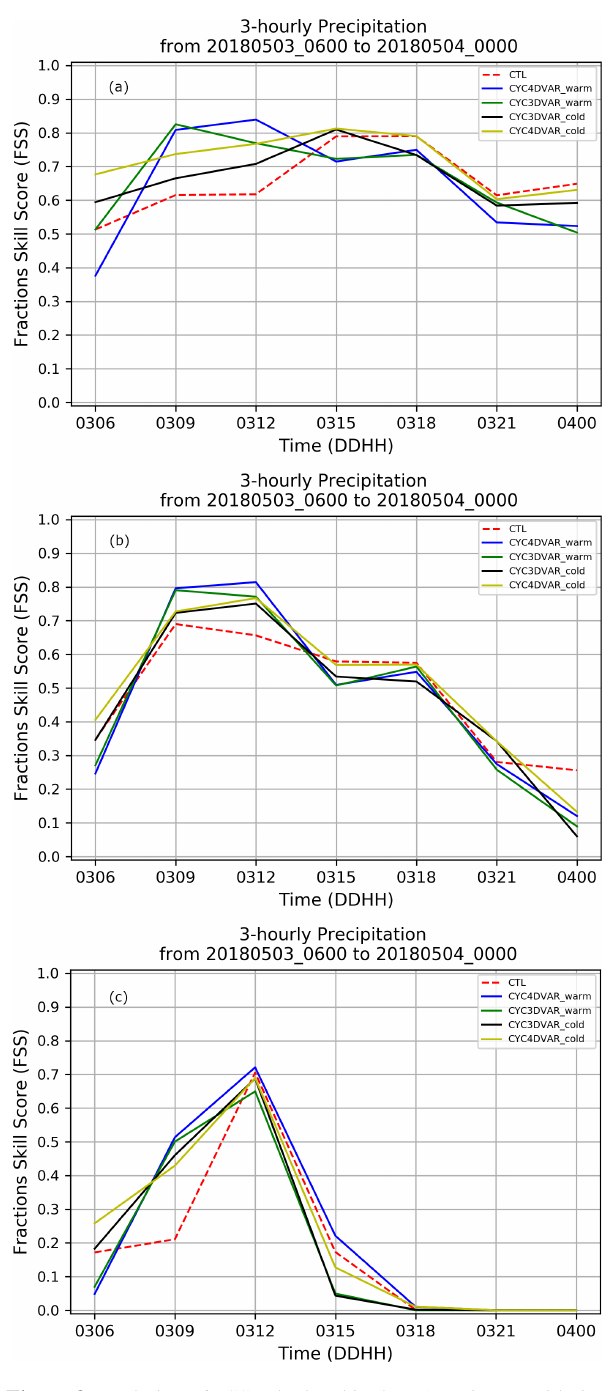
Figure 8. Evolution of FSS calculated in the LA region considering the 3-hourly accumulated precipitation for three threshold values: 1mm3h − 1 (a) , 3mm3h − 1 (b) and 10mm3h − 1 (c) . The dashed red line represents the CTL, the blue line CYC4DVAR_warm, the green line CYC3DVAR_warm, the black line the CYC3DVAR_cold and the yellow line